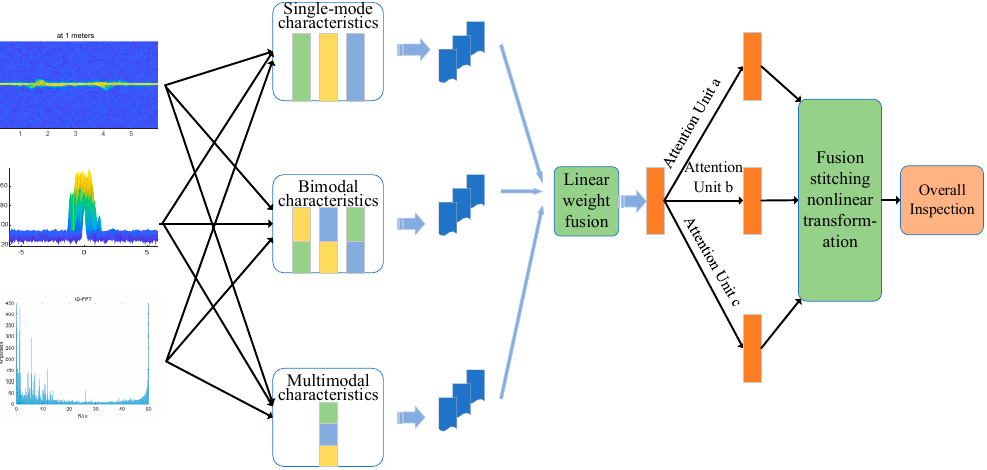
Figure 4. Multimodal attention mechanism for low − rank factor linear weight representation.